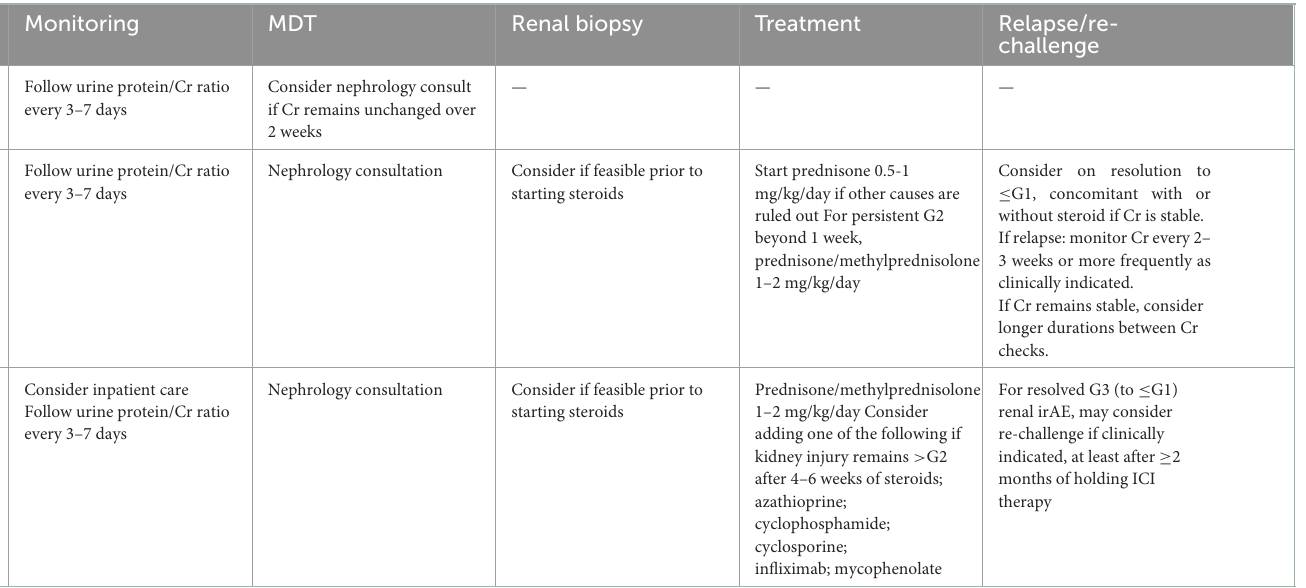
TABLE 2 Management of ICI-AKI in relation to toxicity